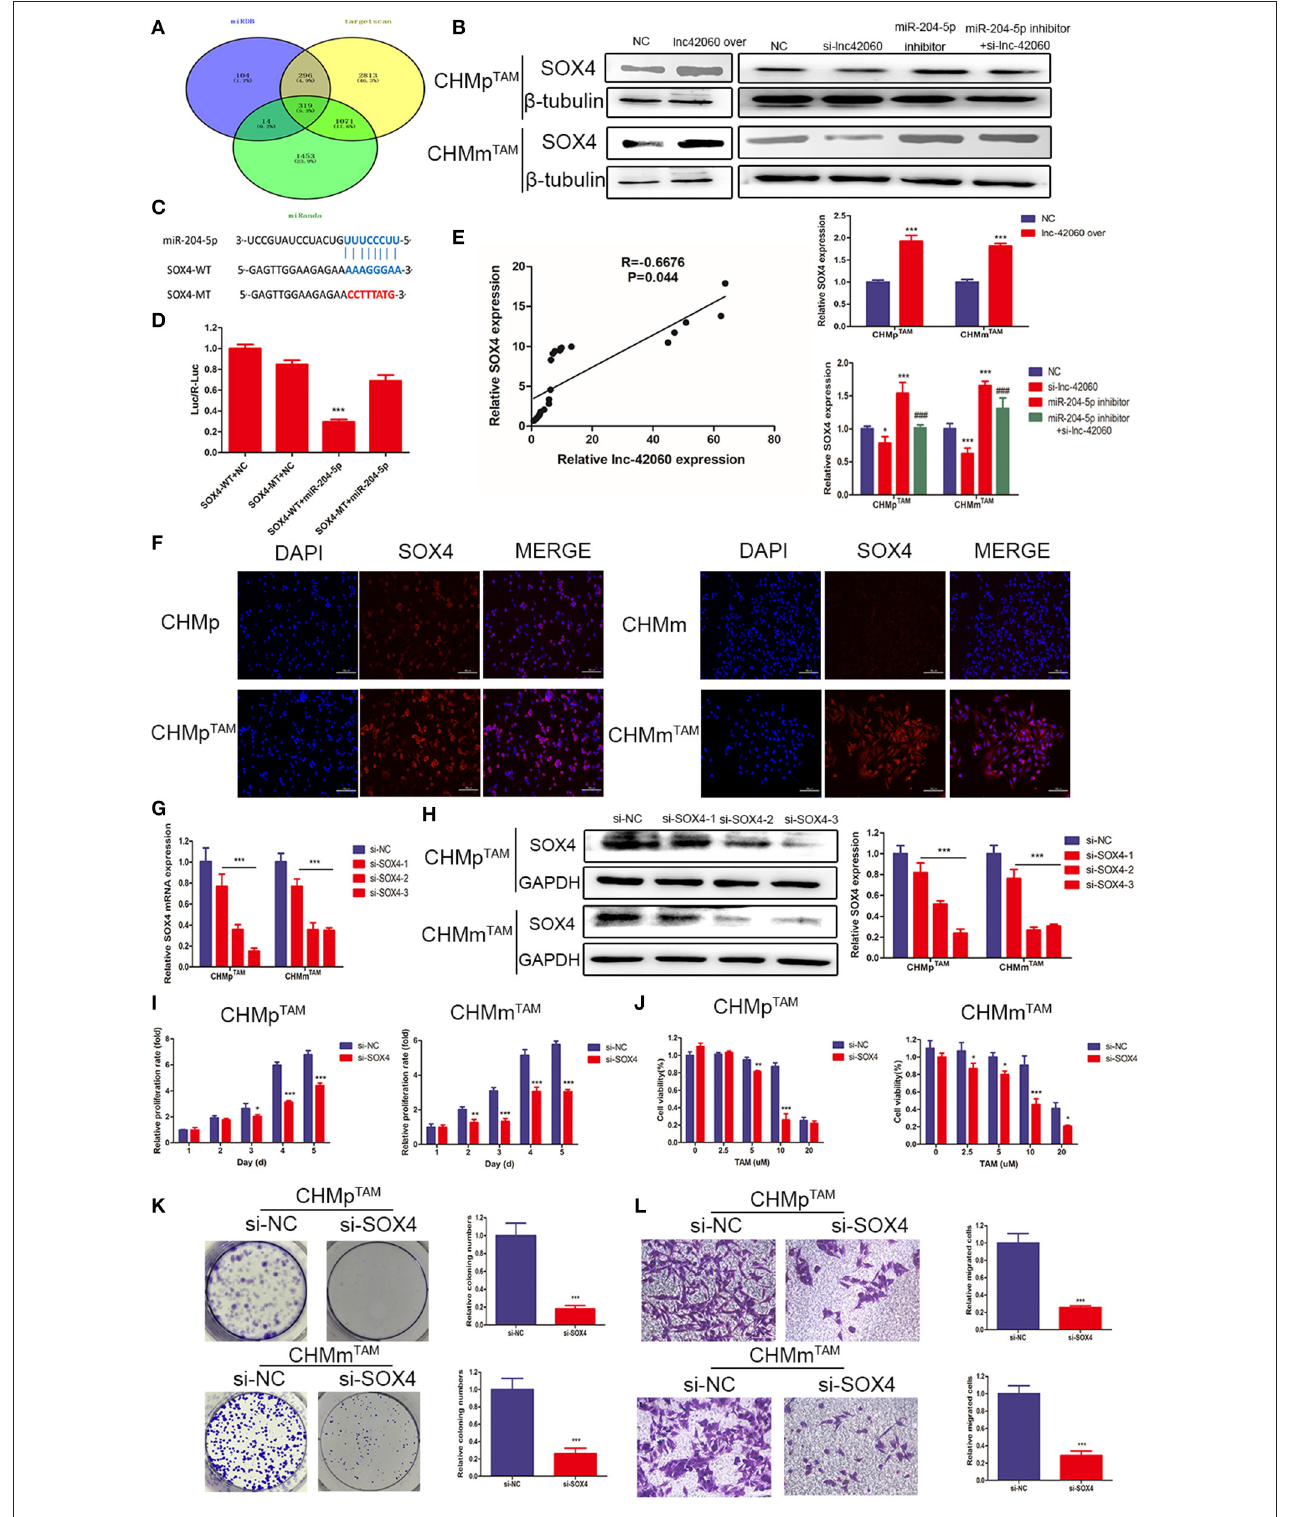
FIGURE 7 | SOX4 is a direct target gene of miR-204-5P and is regulated by lnc-42060. (A) Venn diagram represents the mutual candidate target genes of miR-204-5p identified by miRDB, TargetScan, and miRanda. (B) Expression of SOX4 was tested by Western blot in TAMRs. (C) The predicted potential binding